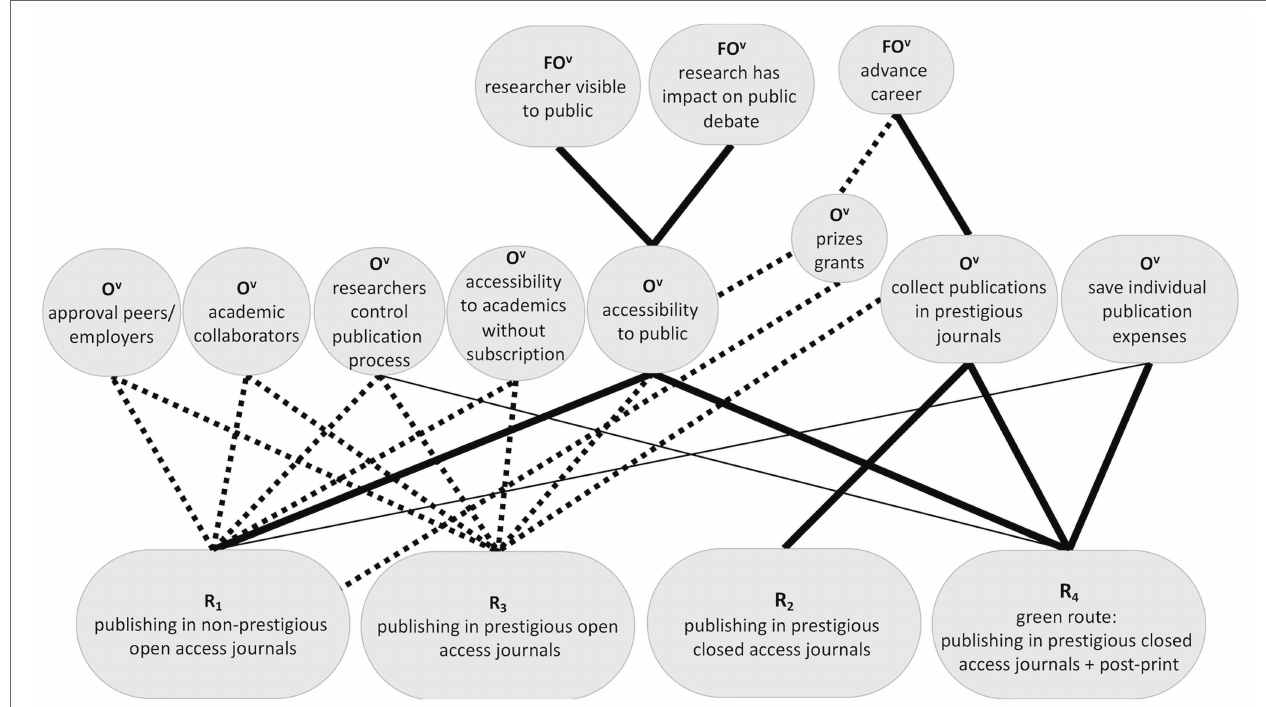
FIGURE 2 | Exemplary goal-hierarchy involved in open access publishing. Thick full lines represent high expectancies of subordinate goals to superordinate goals. Thin full lines represent weak or negative expectancies of subordinate goals to superordinate goals. Thick dotted lines represent interventions that might establish high expectancies of subordinate goals to superordinate goals. R, response or behavior; O v , valued outcome (V = value); and FO v , further valued